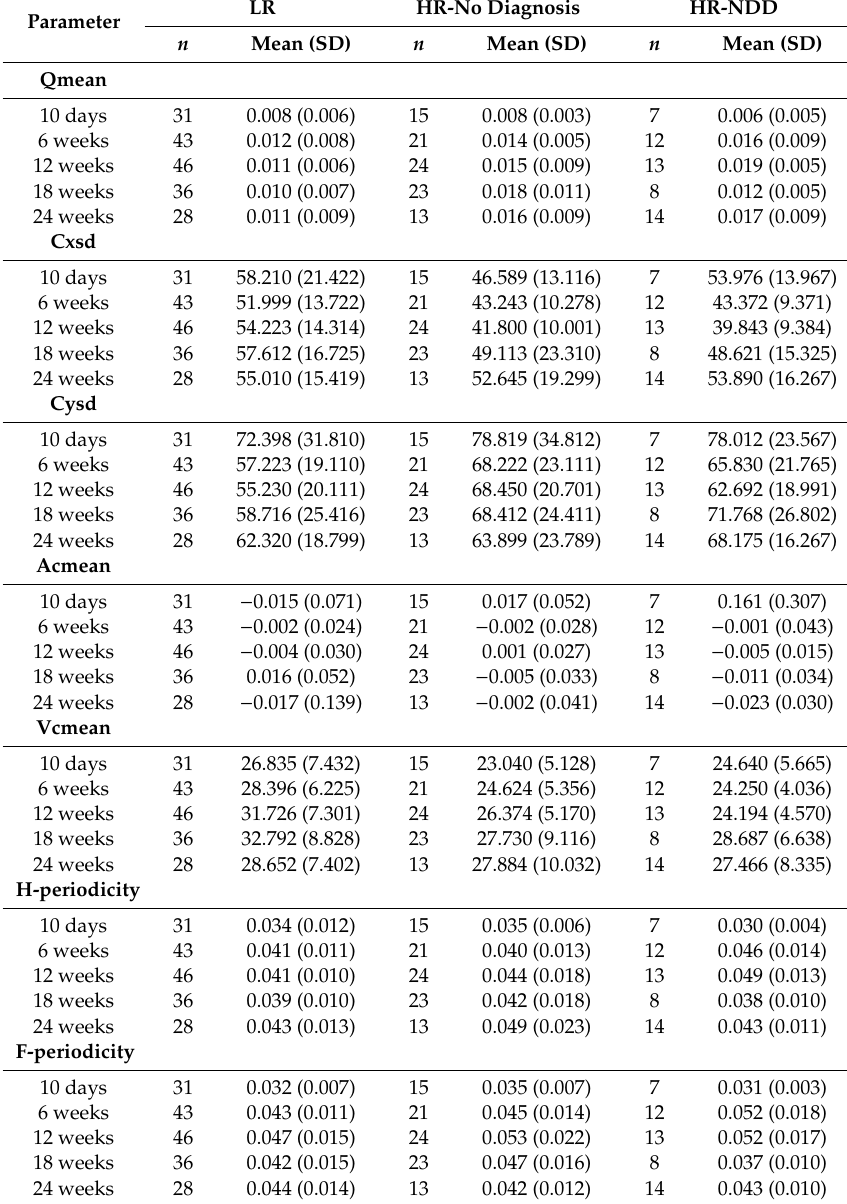
MOVIDEA kinematic parameters’ means (SD) of the three groups of infants (LR, HR-no diagnosis, and